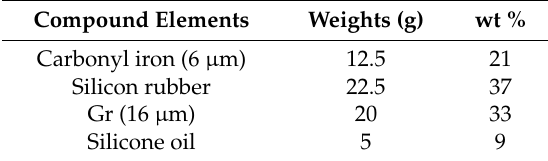
Table 1. Components of the graphite (Gr)-based magnetorheological elastomer (Gr-MRE)